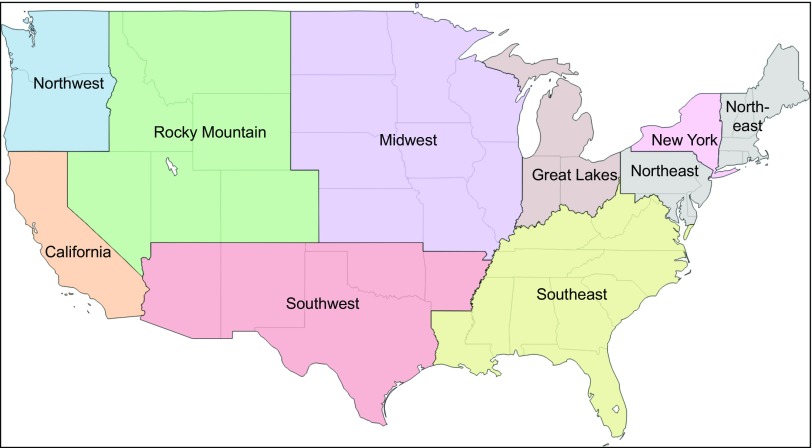
Map indicating the boundaries of each of the nine continental US regions from which a set of milk samples (three different brands of organically produced 2 % milk, three different brands of conventionally produced 2 % milk, and one each of organic and conventional whole milk) were collected in August 2015